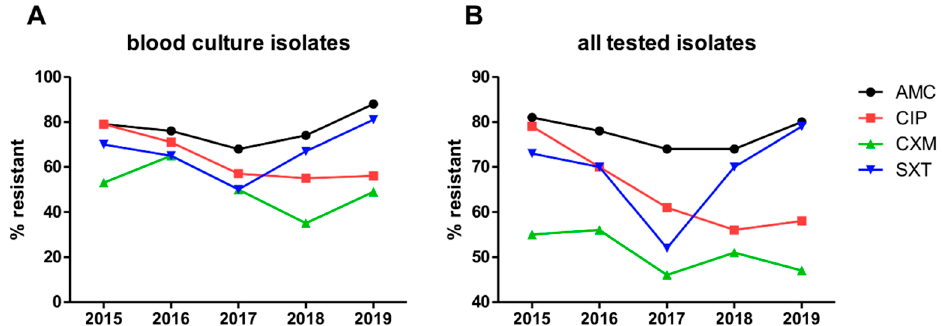
Figure 2. Resistance rates of ( A ) blood culture isolates and ( B ) all tested isolates in the entire hematology department and transplant unit between 2015 and 2019. Abbreviations: AMC, amoxicillin/clavulanate; CIP, ciprofloxacin; CXM, cefuroxime-axetil; SXT, cotrimoxazole.